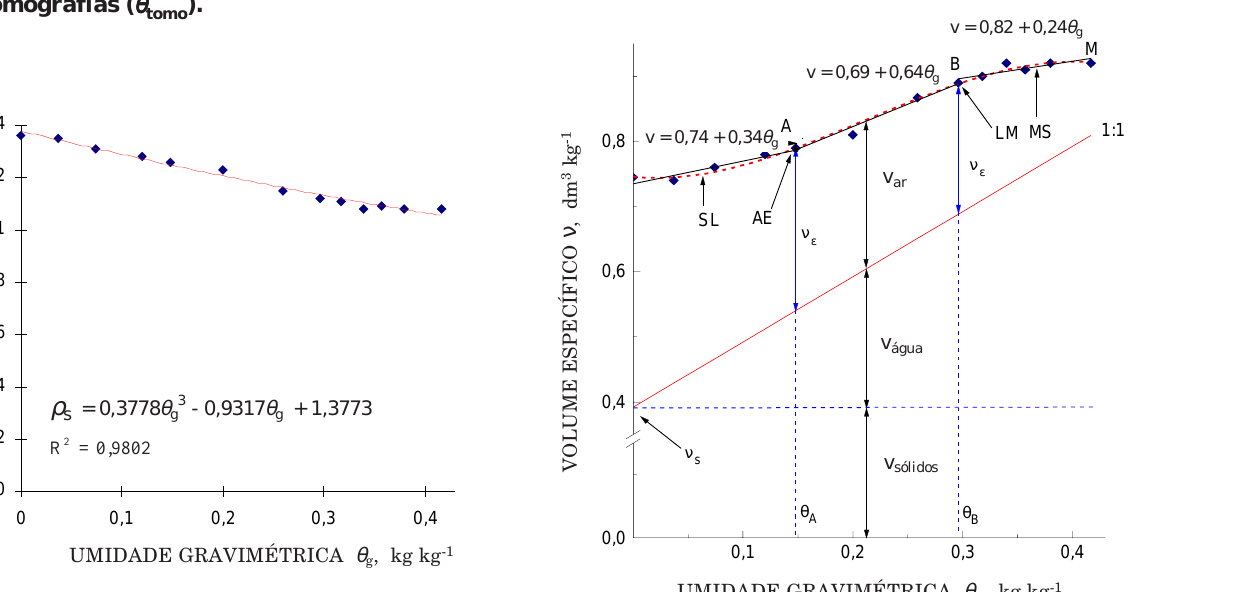
Figura 5. Variação da densidade do solo ( rrrrr função dos diferentes níveis de umidade a que as amostras foram submetidas.